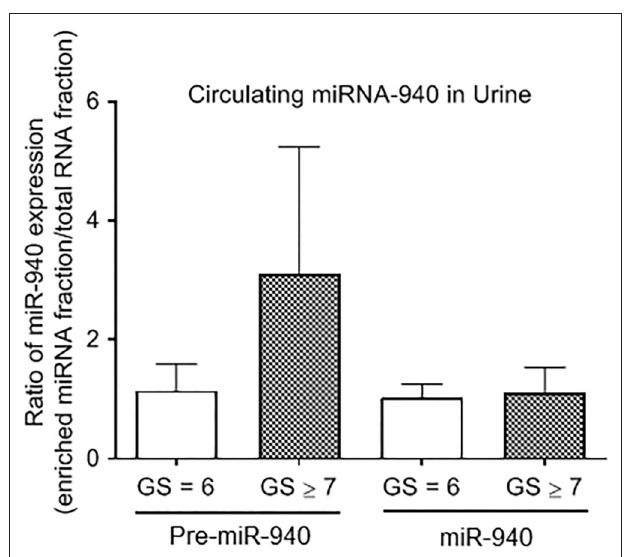
FIGURE 4 | The expression of miR-940 in urine of prostate cancer patients. Relative expression of Pre-miR-940 and miR-940 in the urine from clinically insignificant (GS ≥ 7) prostate cancer patients relative to clinically insignificant (GS = 6) patients ( n = 3 and 5